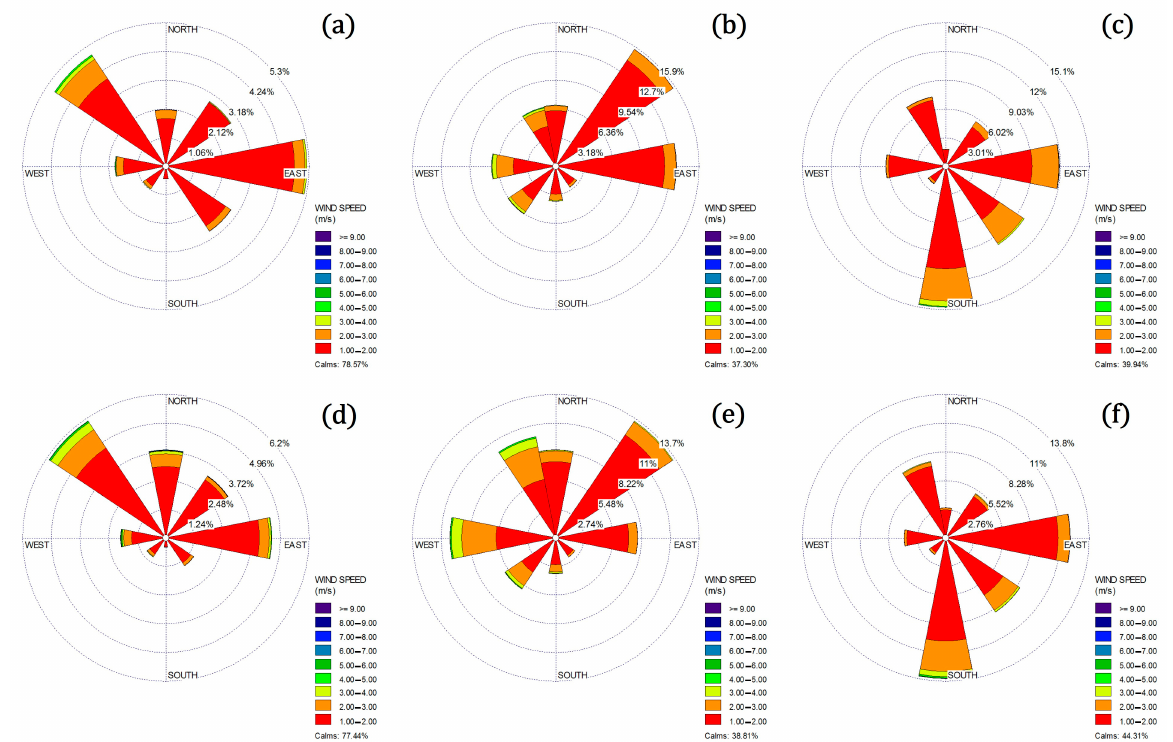
Figure 4. Wind roses with wind speed (m/s) and direction (%) for autumn and winter in Castro ( a , d ), Curitiba ( b , e ), and Paranaguá ( c , f ), respectively.